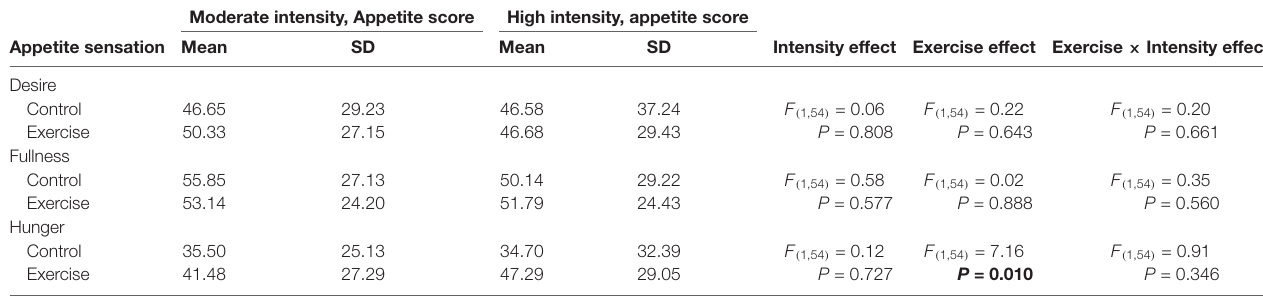
TABLE 4 | Fasting subjective appetite sensations after high- or moderate-intensity exercise and resting control